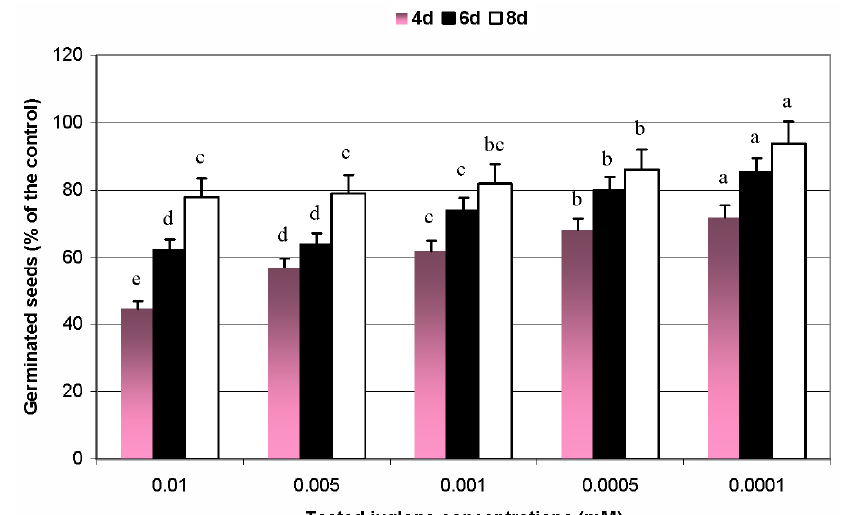
Figure 1. Effects of different juglone treatments on germination process of maize seeds. Values denoted with different letters are statistically significant at p < 0.01 (Duncan’s multiple range test); 100%—number of germinated maize seeds in the control group; d—day of the